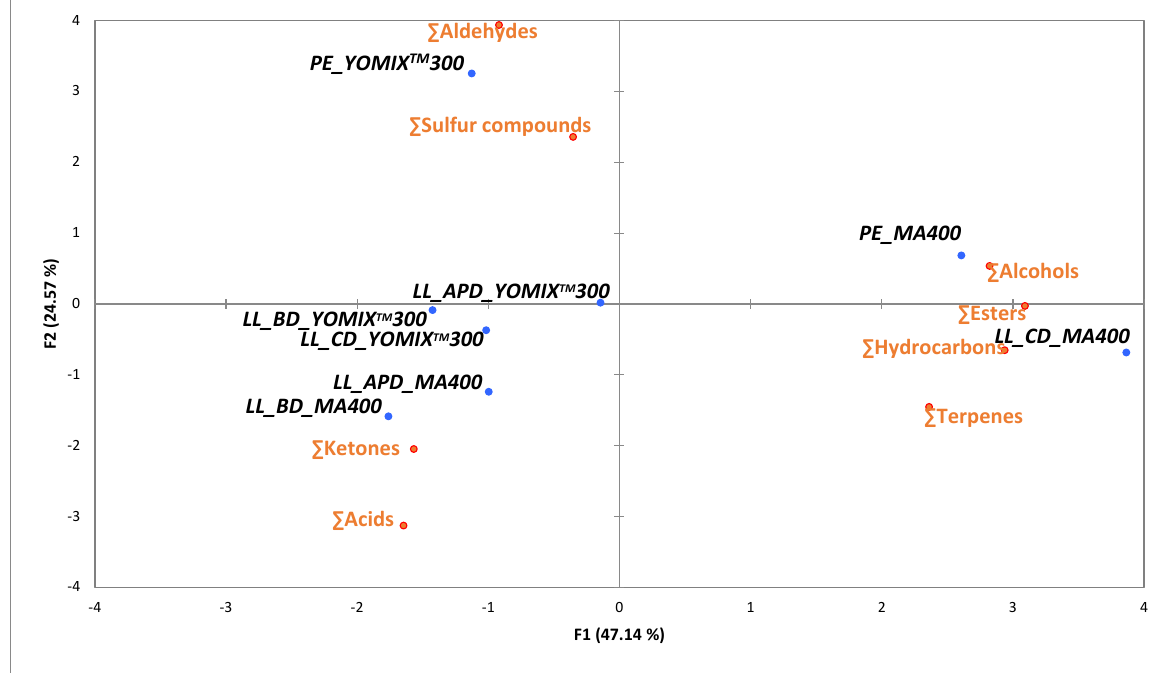
Figure 3. PCA scores plot showing the relationship among different chemical families of volatile compounds in fermented milks at pre-experimental stage (PE) and late lactation stage (LL_CD: conventional fed; LL_BD: broccoli fed; and, LL_APD: artichoke plant fed) by MA400 and YO-MIX TM 300.